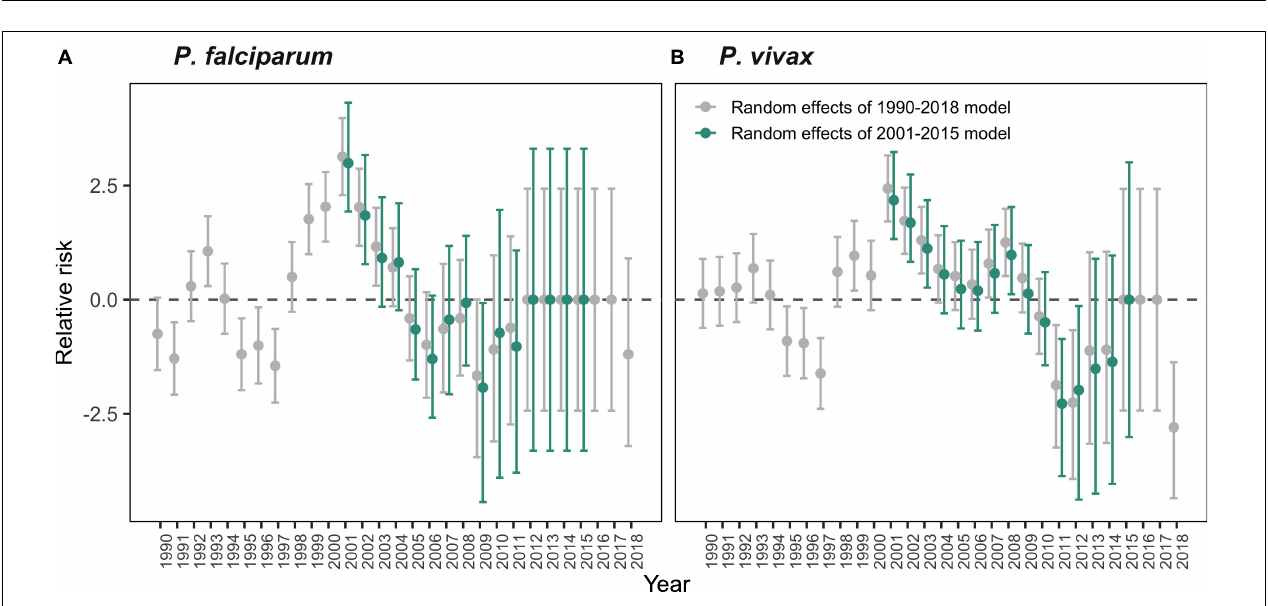
FIGURE 7 | Model improvement for each vector control measure in El Oro 2001–2015. Model improvement, calculated as percentage change in root mean square error (RMSE) between models of P. falciparum and P. vivax malaria excluding each control measure, indoor residual spraying, ULV fumigation, and space spraying, and models including each measure. Positive values (green) show where the addition of the control measure reduces RMSE and negative values (purple) show where including the intervention does not improve the model. Gray areas show missing data.